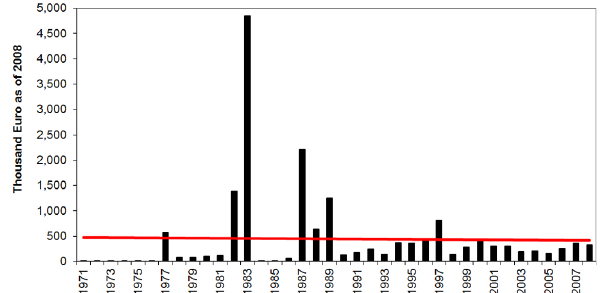
Fig. 3. Spain’s flood insured losses 1971–2008 per million Euros premium paid adjusted for inflation to 2008 (linear trend in red).